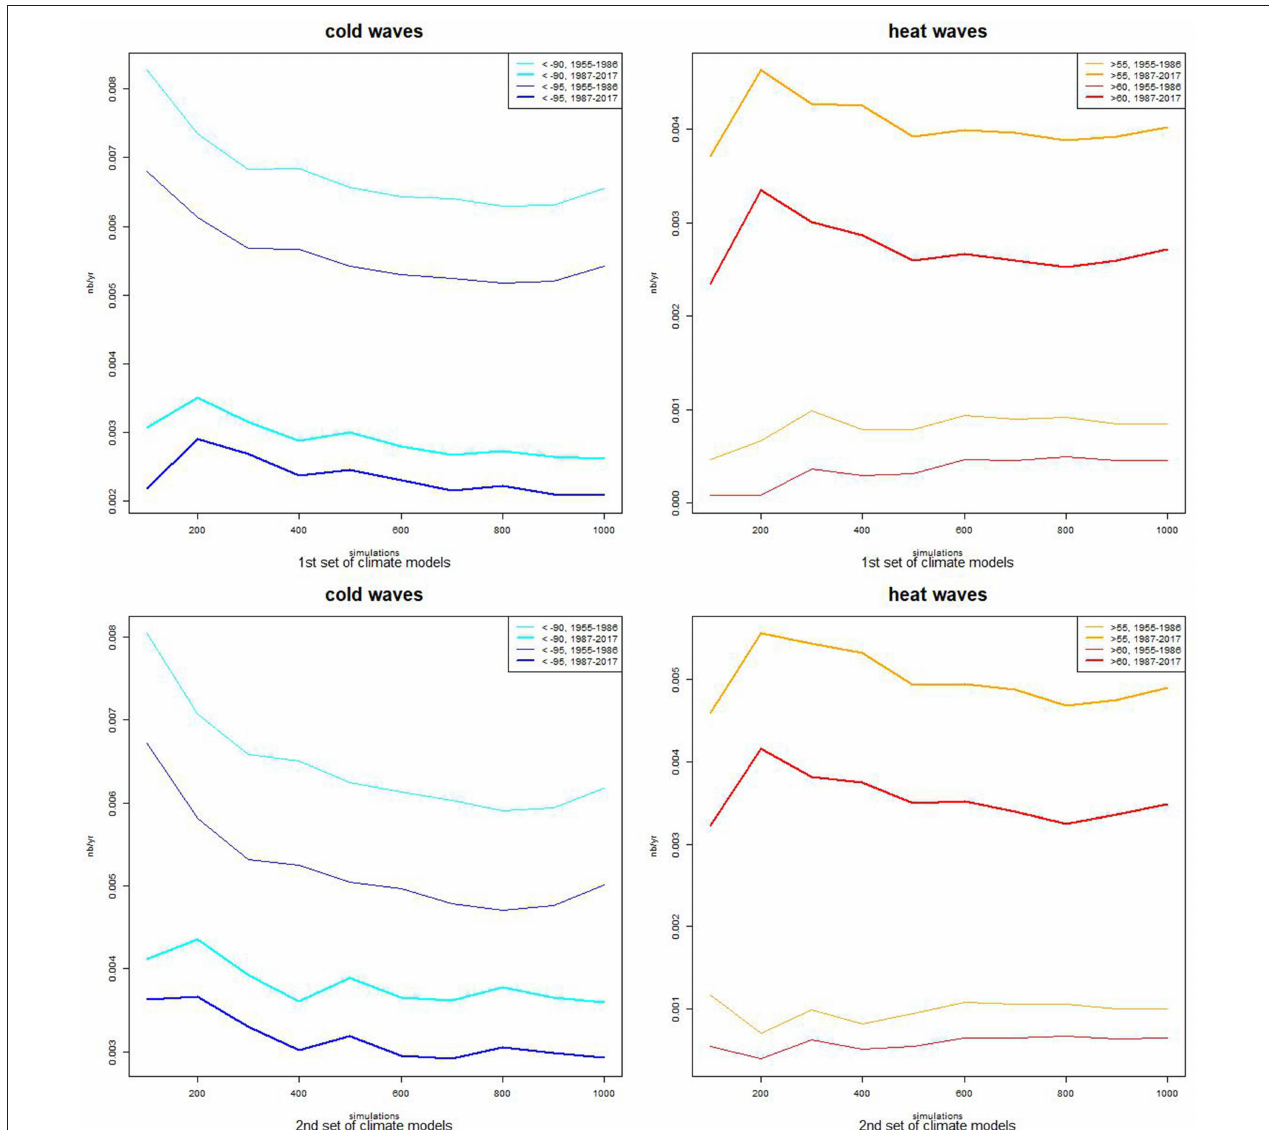
FIGURE 7 | Evolution of the frequency of intense (intensity < − 90, cyan) and very severe (intensity < − 95, blue) cold events as a function of the number of stochastic simulated evolutions of the residuals for period 1955–1986 (thin lines) and 1987–2017 (bold lines) with the first set of four climate models (top left panel); evolution of the frequency of intense (intensity > 55, orange) and very severe (intensity > 60, red) hot events as a function of the number of stochastic simulated evolutions of the residuals for period 1955–1986 (thin lines) and 1987–2017 (bold lines) with the first set of four climate models (top right panel); bottom panels: same as top panels but for the second set of climate